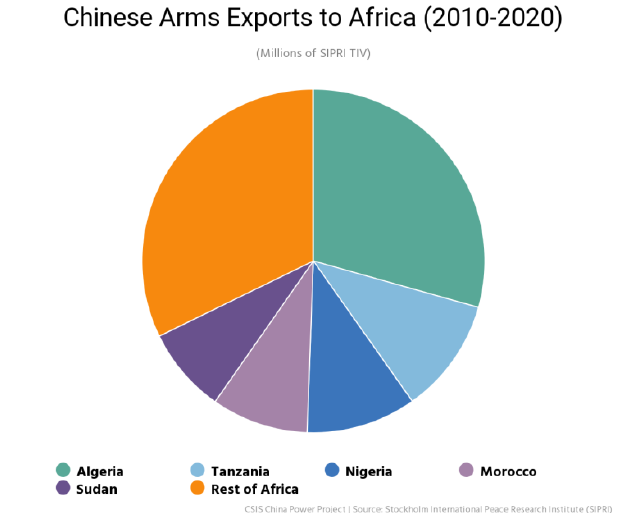
Figure 5: Chinese Arms Export to Africa (2010-2020) (Source: CSIS China Power Project |Source: